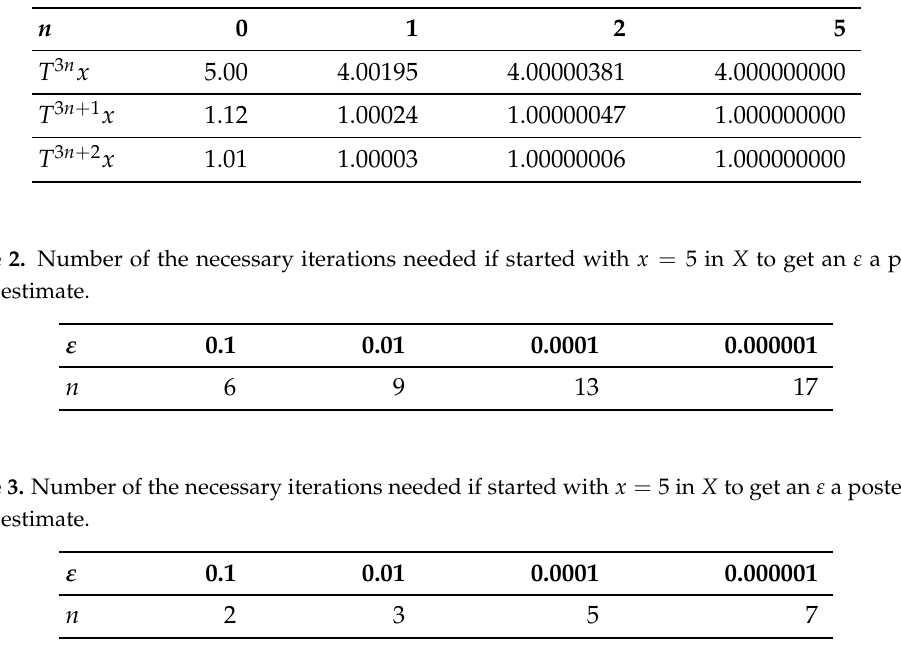
Table 1. The values of the iterated sequence T n x if started with x = 5 in X .